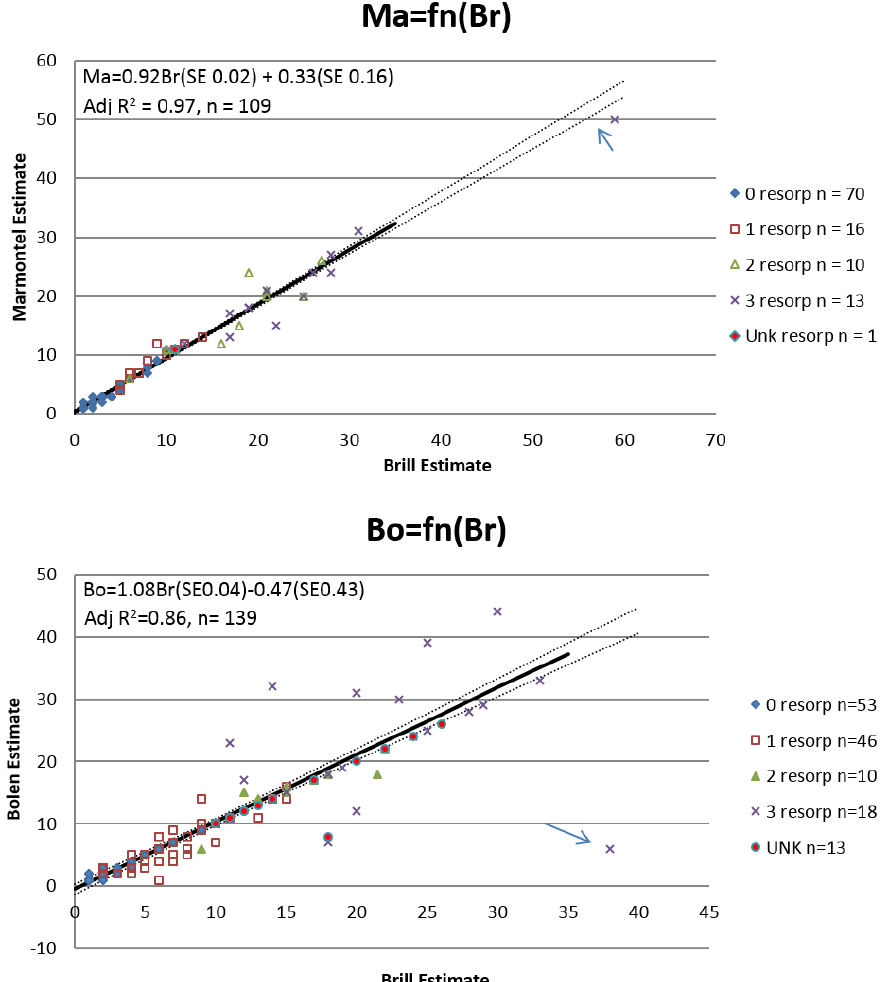
Fig. 3. Regression results comparing age estimates from Marmontel and Brill (upper panel) and Bolen and Brill (lower panel). The fitted line (solid) does not include outliers (arrow) but the 95% confidence intervals (dotted line) were extended to overlap